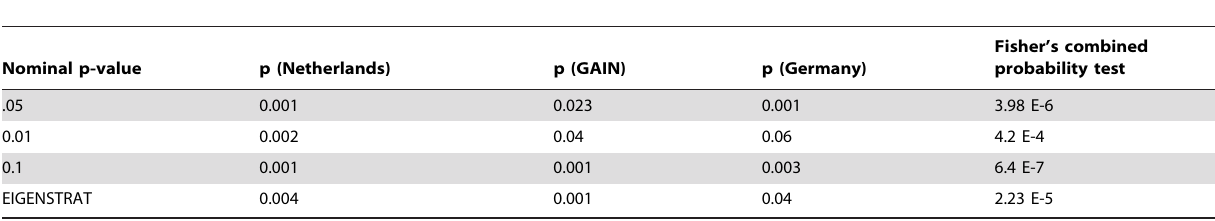
Table 3. Results of the sensitivity analyses: a comparison of different nominal p-values.